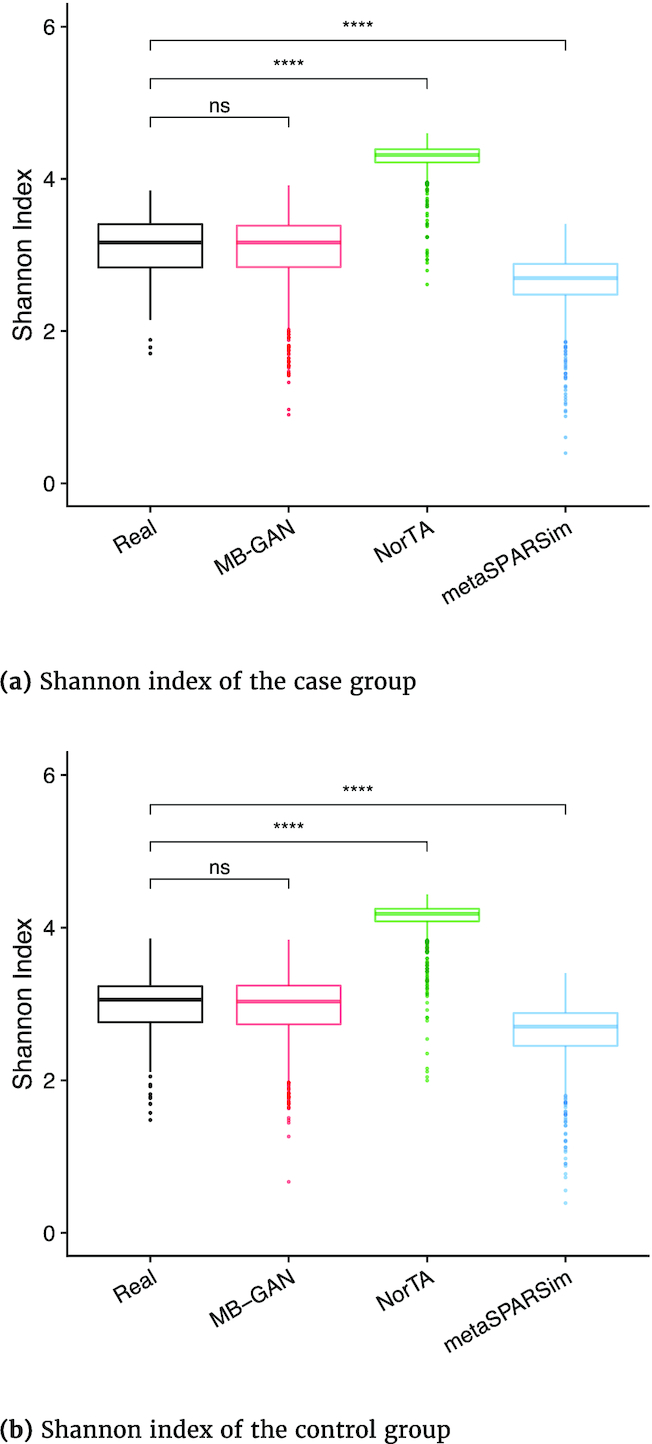
Box plots of Shannon index calculated from real data and 3 simulated datasets (MB-GAN, Normal-To-Anything [NorTA], and metaSPARSim). Notations: ns – not significant; **** – p-value < 0.0001.